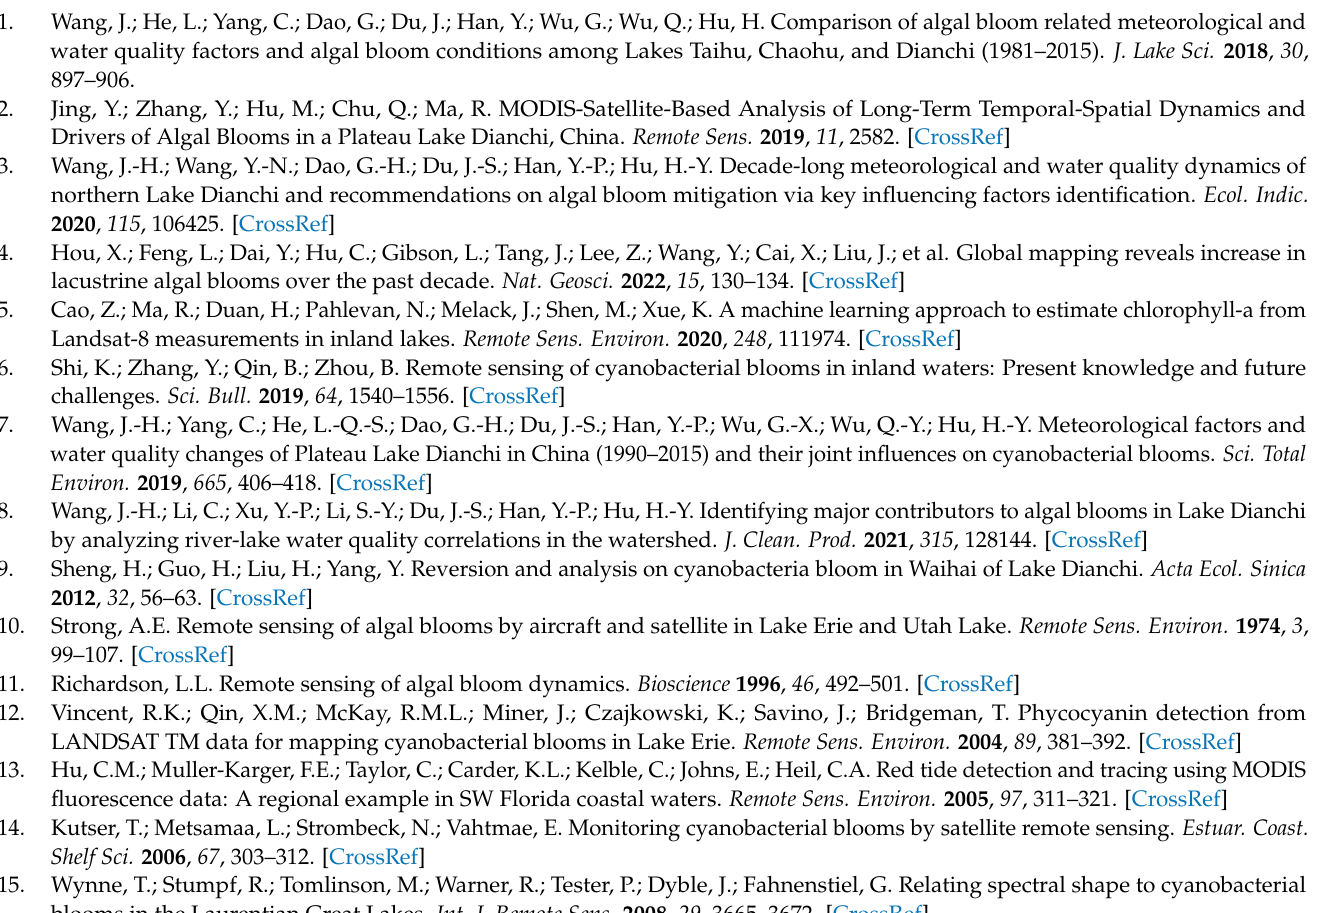
Figure S2: Example of cloud removal with a cloud threshold of R rc,2130 = 0.0246; Figure S3: Statistics of FAI thresholds for Landsat images and MODIS/Terra images; Figure S4: Time series on differ- ent time scales of the maximum bloom area in Lake Dianchi between Landsat and MODIS/Terra (during 2000–2021); Figure S5: Comparison of the algal bloom area derived from MODIS/Terra and Landsat